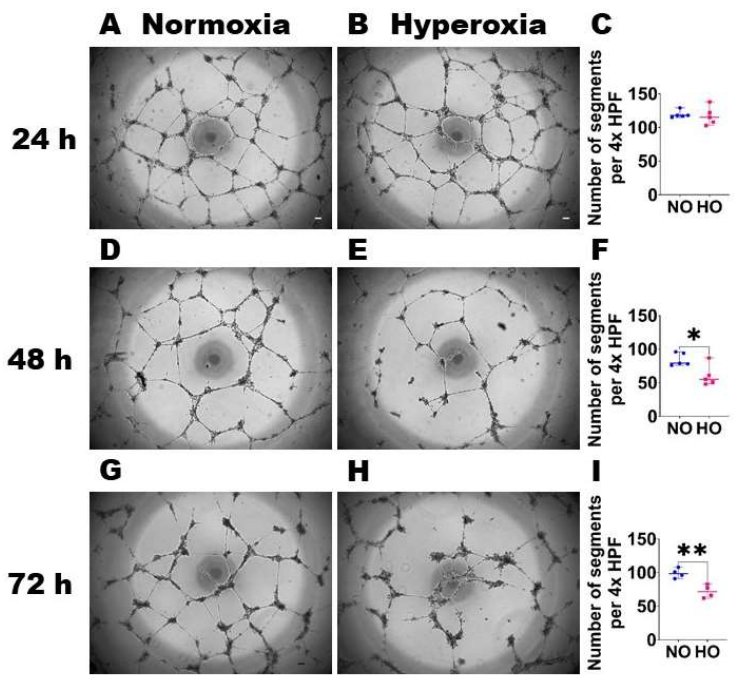
Figure 2. Effects of HO exposure on HDLEC tubule formation. Tubule formation assay was performed at the indicated time points on cells grown on six-well plates to 60% confluence and exposed to NO (21% O 2 and 5% CO 2 ) or HO (70% O 2 and 5% CO 2 ) for up to 72 h. A, B, D, E, G, and H. Representative photographs showing tubule formation of NO ( A , D , G ) and HO ( B , E , H ) exposed cells at 24 h ( A , B ), 48 h ( D , E ), and 72 h ( G , H ). Scale bar = 100 µm. C, F, and I. Quantification of tubule number at 24 h ( C ), 48 h ( F ), and 72 h ( I ). Values are presented as the median with the range ( n = 4– 5/group). Significant differences between exposures are indicated by *, p < 0.05, **, p < 0.01 ( t -test). Expression of antioxidant enzymes in HDLECs following HO exposure : Since oxida- tive stress can disrupt endothelial cell homeostasis by affecting the expression of angio- genic molecules and impairing the tubule-forming capability of these cells, we also quan- tified the expression of the well-known antioxidant enzymes, NQO1 and HO1, by real- time RT-PCR analysis in our in vitro model. HO affected the NQO1 mRNA expression in a biphasic manner, with increased expression after 24 h (Figure 3A) and 72 h (Figure 3E) of exposure and no effect after 48 h (Figure 3C) of exposure compared to NO exposure for identical periods. In contrast, HO exposure increased HO1 mRNA expression at all three- time points compared to NO exposure (Figure 3B,D,F), with a peak effect occurring at 48 h (Figure 3D).